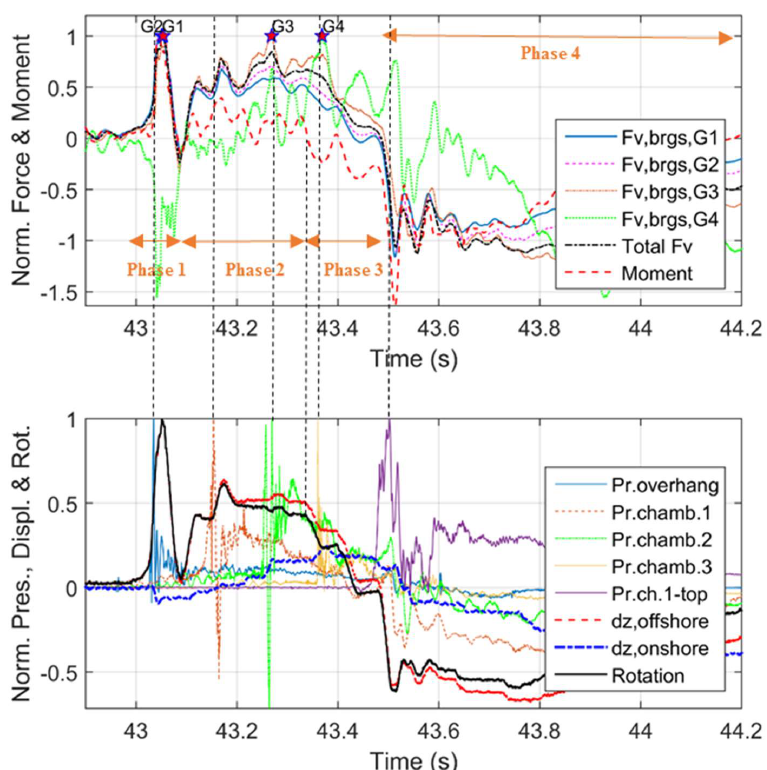
Figure 5. Time histories of normalized vertical forces and moments ( top ), and normalized pressures, vertical displacements and cumulative rotations ( bottom ) for H = 0.55m.